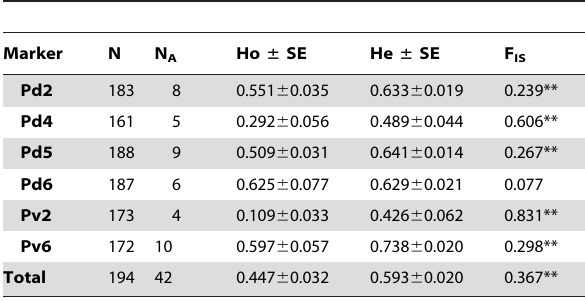
Table 1. Population genetic indices for the six microsatellite